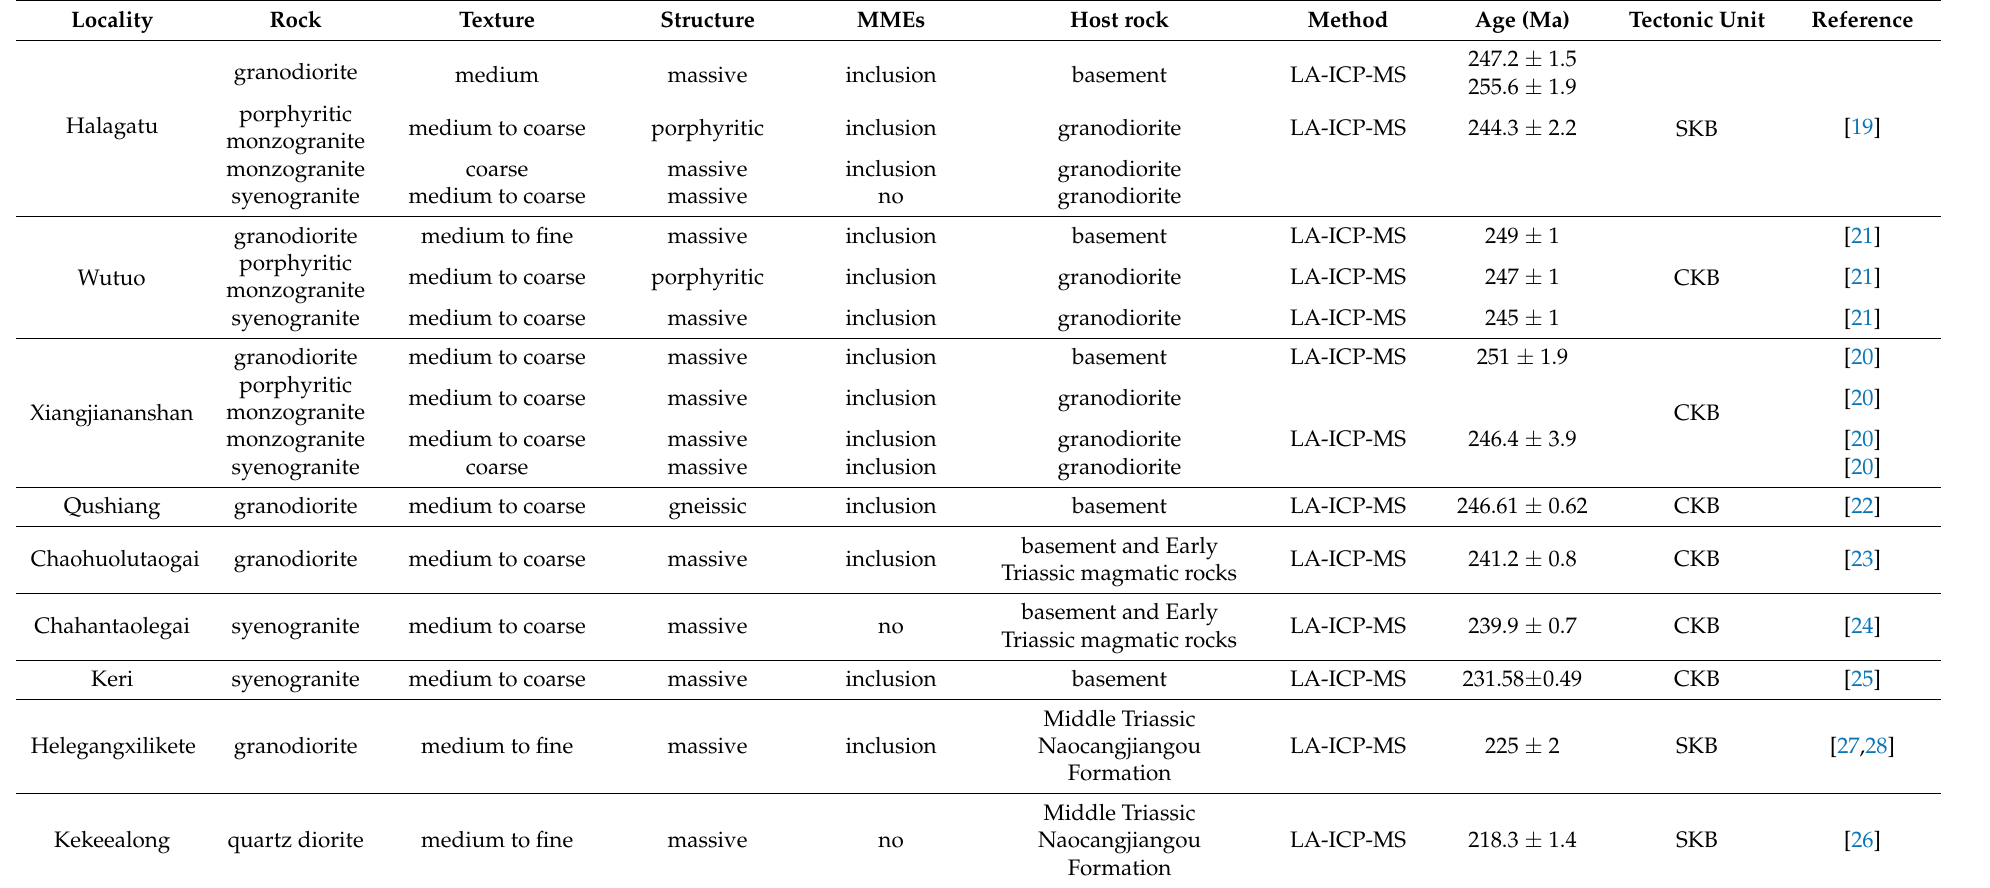
Table 1. Geological characteristics of the Indosinian granite in eastern region of EKO